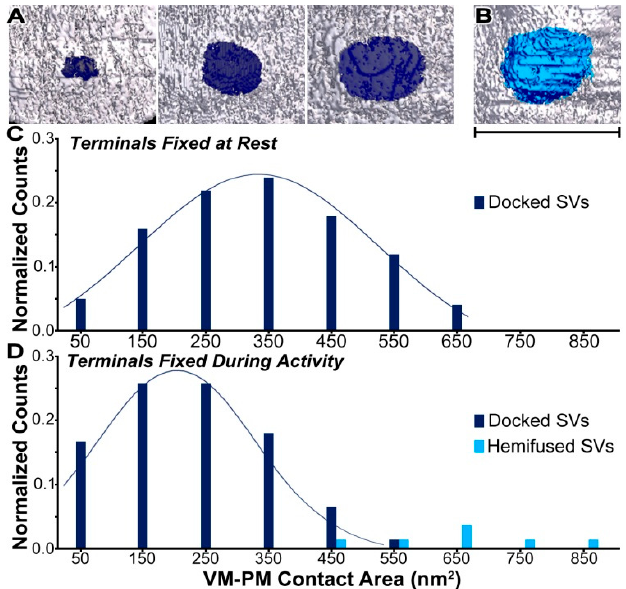
Figure 3. Vesicle membrane–presynaptic membrane (VM–PM) contact areas of docked synaptic vesicles (SVs) at the active zones, fixed at rest and during the repetitive electrical nerve stimulation at 10 Hz. ( A ) The VM–PM contact areas for three docked SVs (dark blue) in terminals fixed at rest were mapped on surface models of the PM, from the cytoplasmic side of each of the active zone. The extents of the marked contact sites of the vesicles show that their contact areas are di ff erent in size. Based on the number of pixels within the perimeter of the contact sites projected onto best-fit planes, the VM–PM contact areas (left, middle, and right) were 60 nm 2 , 300 nm 2 , and 600 nm 2 , respectively. ( B ) The contact site of a docked synaptic vesicle hemifused with the presynaptic membrane was mapped on the surface model of the presynaptic membrane (teal-blue). The extent of the contact area is 630 nm 2 . Scale bar is 50 nm for A and B . ( C ) The histogram of the VM–PM contact areas of the 101 docked SVs, measured as in A , in terminals fixed at rest. The area varies more than 13-fold, with a normal distribution across the population (330 ± 150 nm 2 ; mean ± SD). The bin size is 100 nm 2 . ( D ) The histograms of the contact areas of the 74 docked synaptic vesicles without hemifusion (dark blue) and seven hemifused synaptic vesicles (cyan). The average contact area and standard deviation of the docked vesicles without hemifusion is 220 nm 2 ± 120 nm 2 (mean ± SD). The average contact area of the hemifused synaptic vesicles (660 nm 2 ± 150 nm 2 ; mean ± SD) is greater than the average area of the docked synaptic vesicles without hemifusion (Mann–Whitney U test, p < 0.01). Adapted from Jung et al. 2016 [45].